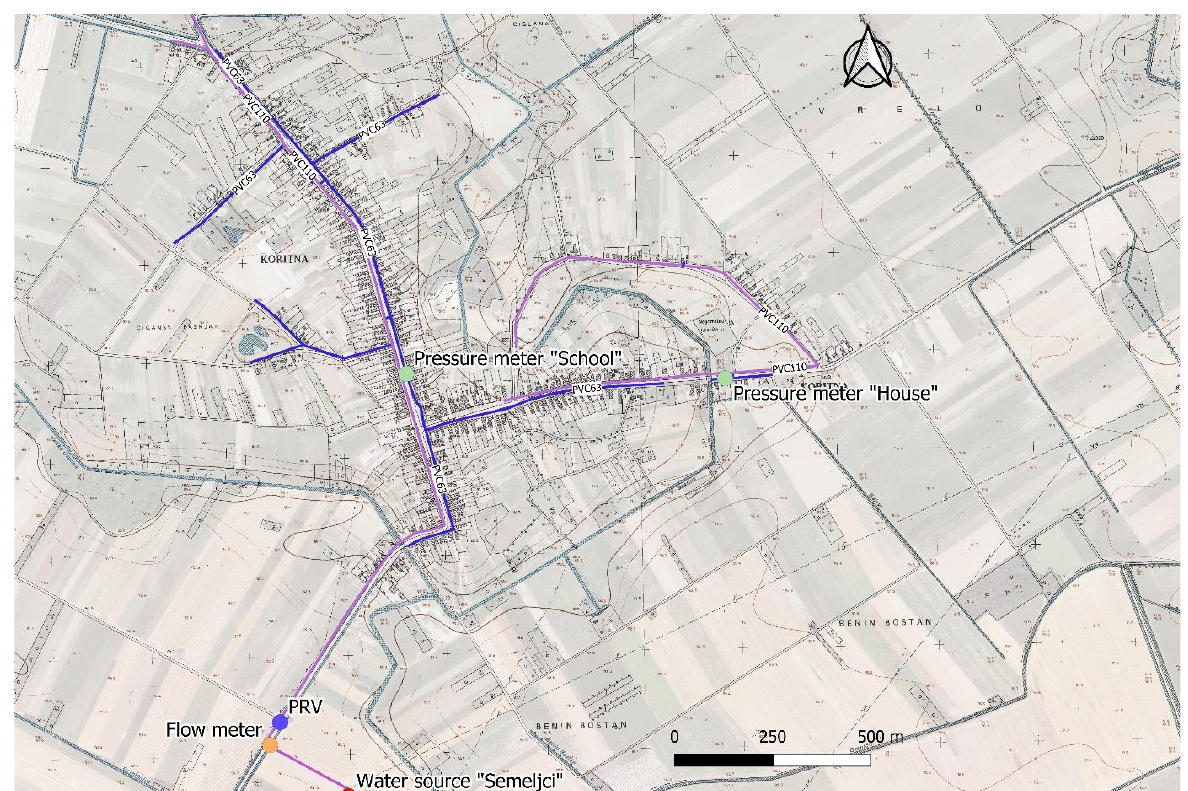
Figure 3. Experiment